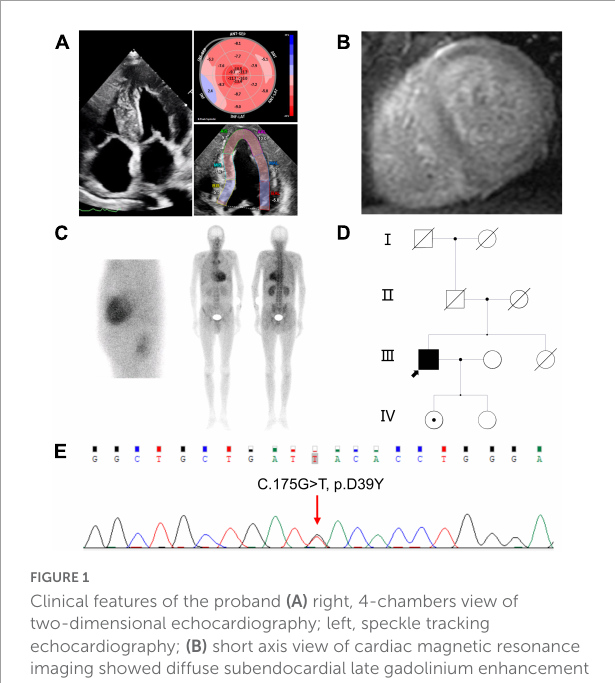
FIGURE1 Clinical features of the proband (A) right, 4-chambers view of two-dimensional echocardiography; left, speckle tracking echocardiography; (B) short axis view of cardiac magnetic resonance imaging showed diffuse subendocardial late gadolinium enhancement in ventricular walls; (C) Tc-99m-PYP scintigraphy revealed grade 3 myocardial uptake, and HCL ratio was 2.38; left, planar myocardial imaging; right, planar whole-body imaging; (D) pedigree of the family. The black arrow represents the proband, dot in the center of the circle represent female carrier: (E) Sequence analysis of exon 2 of the TTR gene. The proband showed a homozygous missense variant with a G > T change at nucleotide 175. PYP: Pyrophosphate. HCL: Heart/contralateral lung ratio. TTR, Transthyretin.